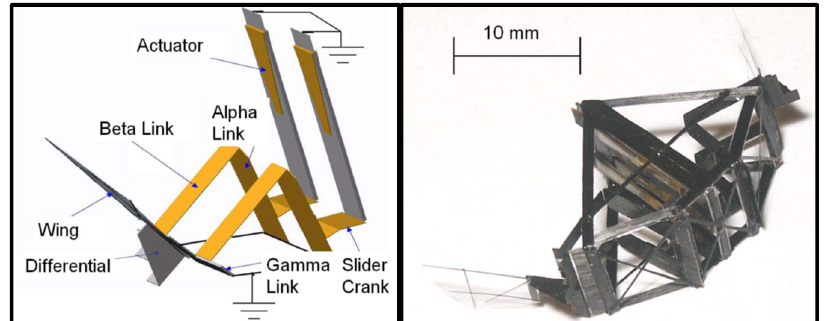
Figure 4. FWMAV with four degrees-of-freedom.